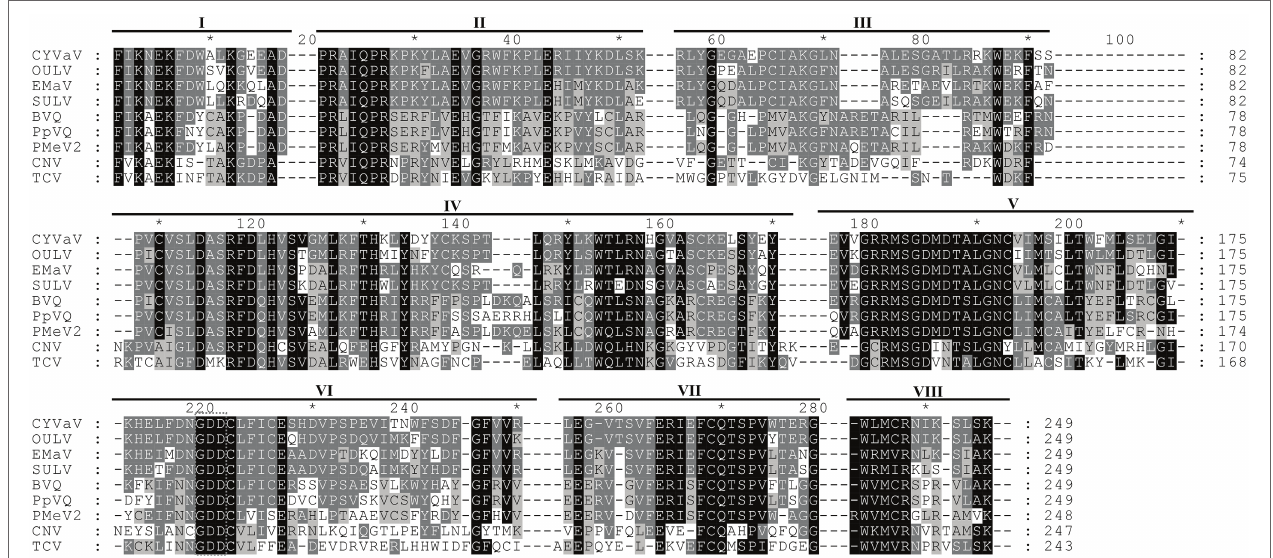
FIGURE 3 | Alignment of the amino acid sequences of the conserved domains of RdRp of CYVaV and related unclassified virus-like RNAs of the family Tombusviridae . Opuntia umbra-like virus (OULV), Ethiopia maize-associated virus (EMaV), sugarcane umbra-like virus (SULV), babaco virus Q (BVQ), papaya virus Q (PpVQ), and papaya meleira virus 2 (PMeV2). The viruses cucumber necrosis virus (CNV, Tombusvirus ) and TCV ( Carmovirus ) were used as guidelines for the identification of the eighth conserved RdRp domains (marked as I–VIII) per Koonin (1991). The numbering above the alignment is arbitrary, starting from the first aligned residue. Amino acids present in at least two sequences were highlighted with different shades of gray as prepared by GeneDoc v2.7.00 (Nicholas and Nicholas,